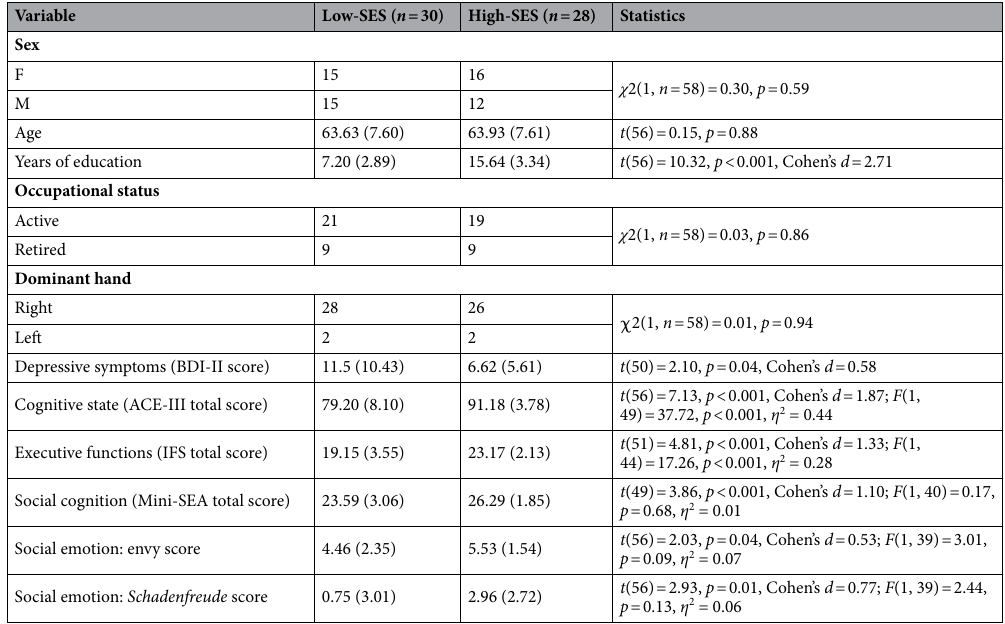
Table 1. Groups’ demographics and experimental variables. Data are presented as mean ( SD ) except for sex, occupational status, and handedness. Categorical variables were analyzed with Chi square tests. Continuous variables were analyzed with Student’s independent-samples t -tests and ANCOVA (see details in “Methods” section). ACE-III: Addenbrooke’s Cognitive Examination-III; BDI-II: Beck Depression Inventory-II; IFS: INECO Frontal Screening; Mini-SEA: Mini-Social Cognition and Emotional Assessment; SES: socioeconomic